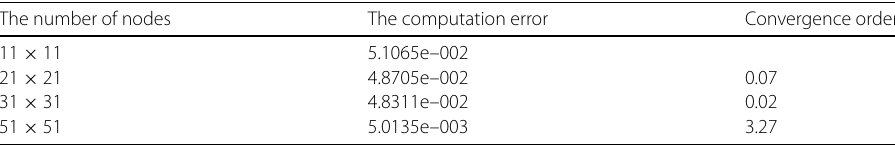
Table 6 The convergence order of the proposed method L1-TFPM as γ = 0.8 The number of nodes The computation error Convergence